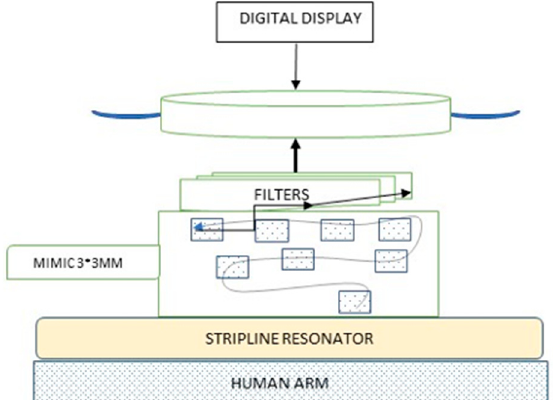
Figure 1. The HGR glucose meter design. The RF wave is generated in the patient arm. The return wave is cleared from all signals other than glucose by specialized filters. The uniqueness of the glucose meter lies in the dielectric plate and the filters.